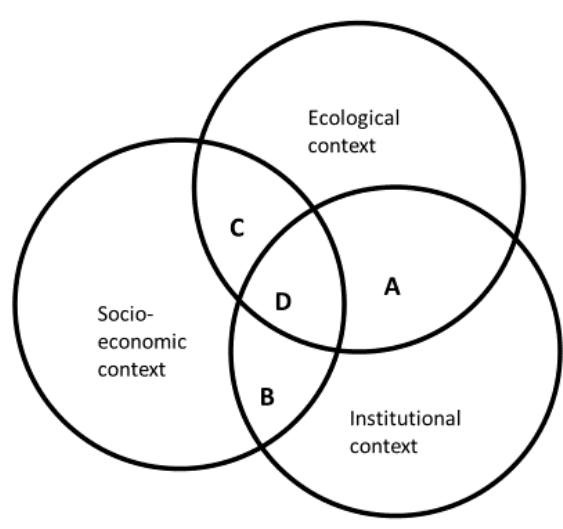
Figure 1. Zones of Ecosystems Management. Source: Modified from Meffe, [34].